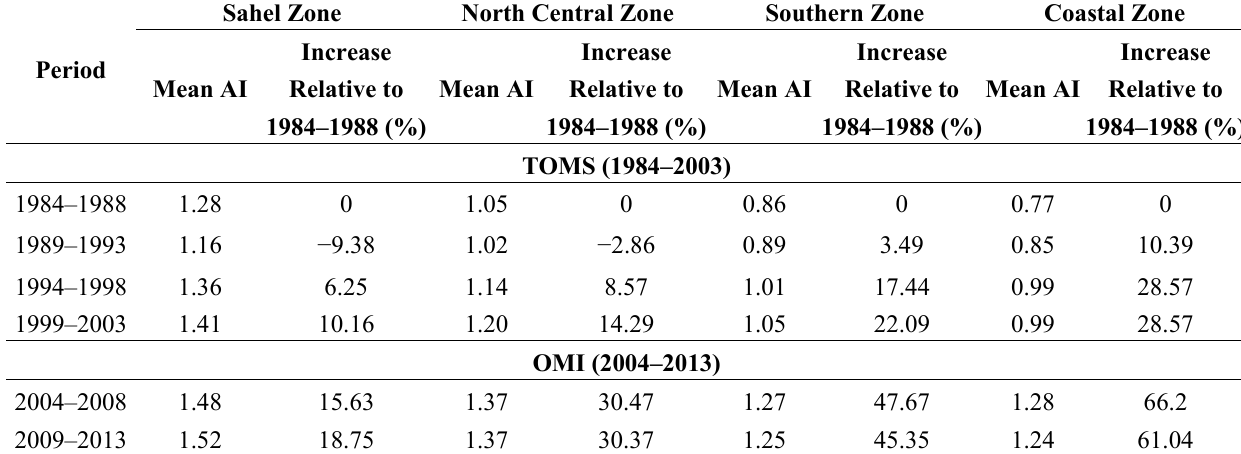
Table 5. Five years interval average Total Ozone Mapping Spectrometer (TOMS) and Ozone Monitoring Instrument (OMI)Aerosol Index (AI)change for all the zones of Nigeria. Sahel Zone North Central Zone Period Mean AI